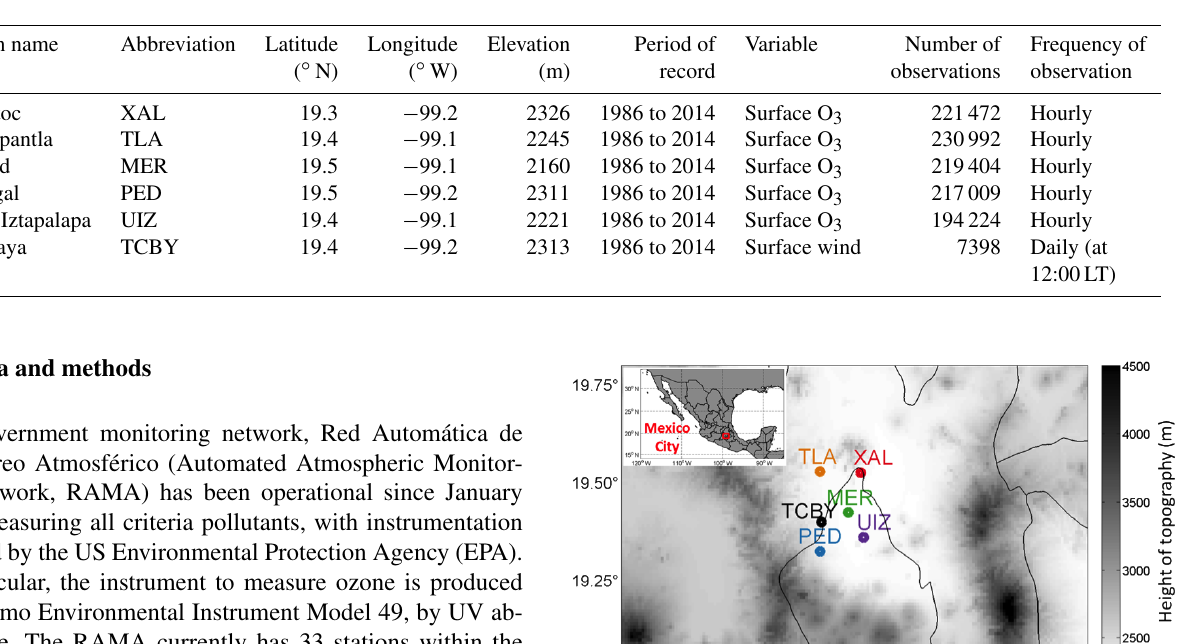
Table 1. Station names, locations, period of record, and number and type of observations.